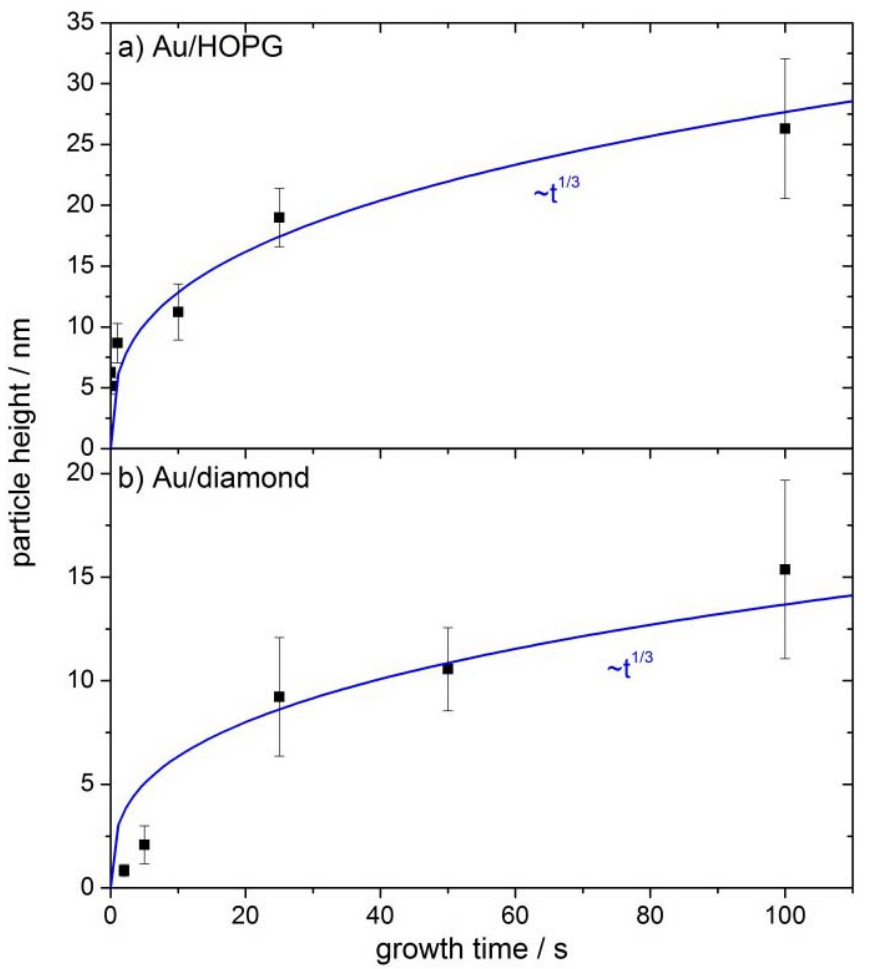
Figure 4. Average particle height versus growth time for Au nanoparticles on HOPG ( a ) and diamond ( b ). The error bars denote the standard deviation σ of particle heights.